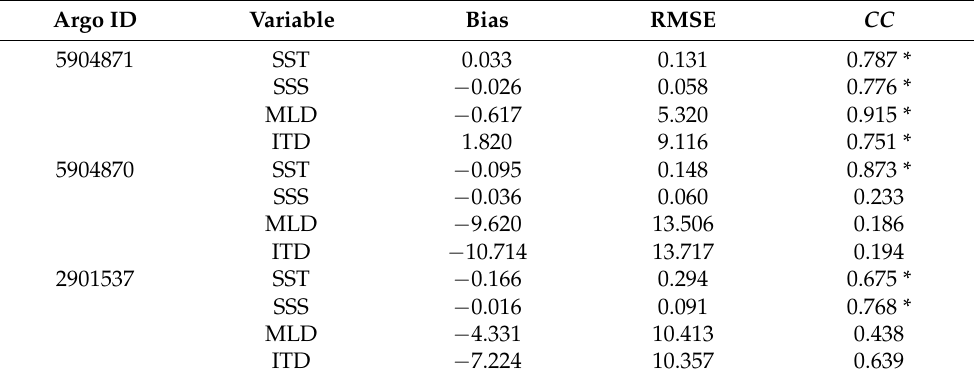
Figure 11. Ocean response to super-typhoon Haiyan in oceanic reanalysis HYCOM. The data are interpolated to Argo-following grids, as in Figure 9. ( a – c ) Profiling observations of temperature in HYCOM for Argo ID 5904871, 5904870 and 2901537, respectively. ( d – f ) The corresponding salinity profiles in HYCOM. Table 4. Statistics on SST (unit: ◦ C), SSS (unit: psu), MLD (unit: m) and ITD (unit: m) between Argo float and HYCOM.The comparisons are performed during 2 November to 15 November. The negative (positive) bias in MLD or ITD indicates the depth in HYCOM is shallower (deeper) than that in Argo. The asterisk in CC represents the CC passing 0.05 significant